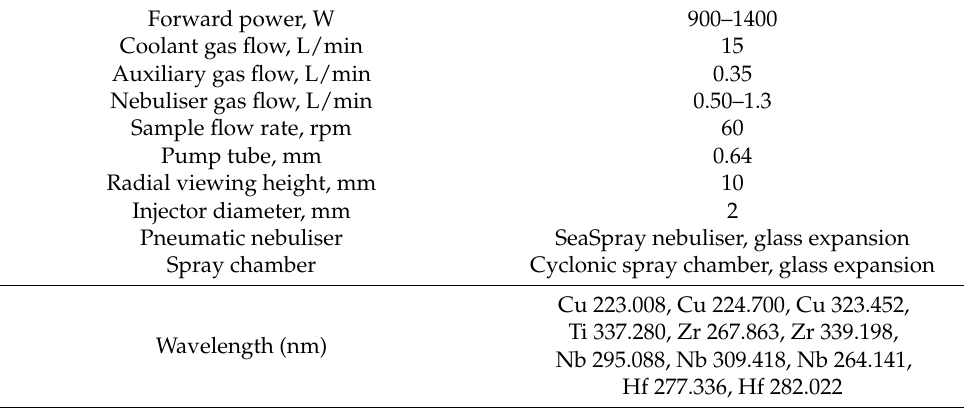
Table 1. Instrumental operating conditions of ICP-OES measurements.